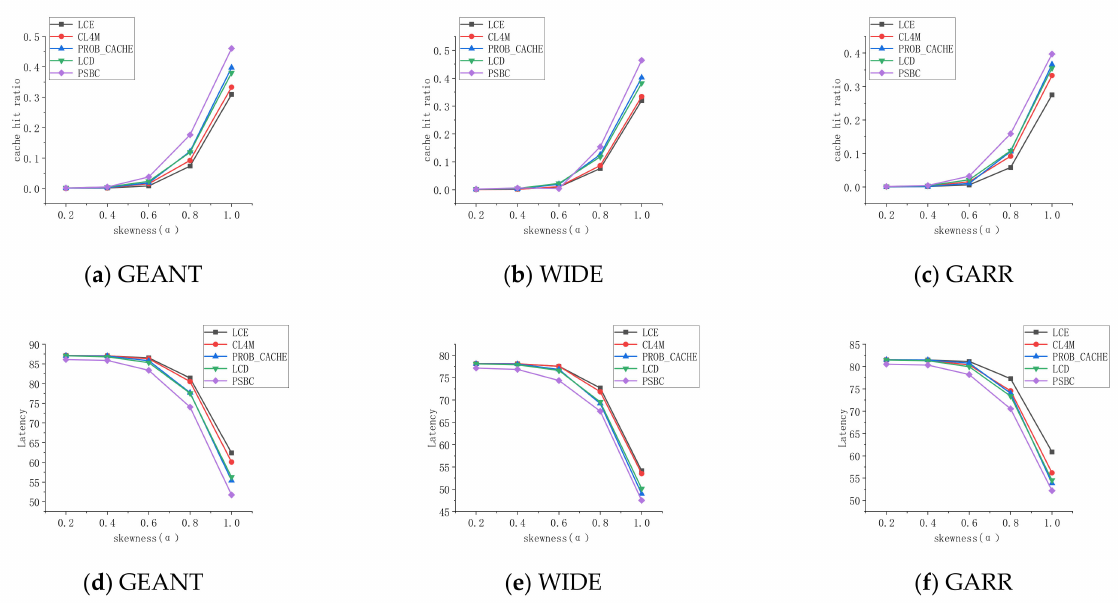
Figure 4. Cache performance with different skewness values ( α